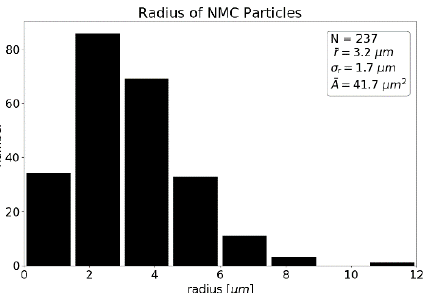
Figure 3. Histogram of particle radii of an NMC 111 lithium-ion battery cathode from the Blob analysis.